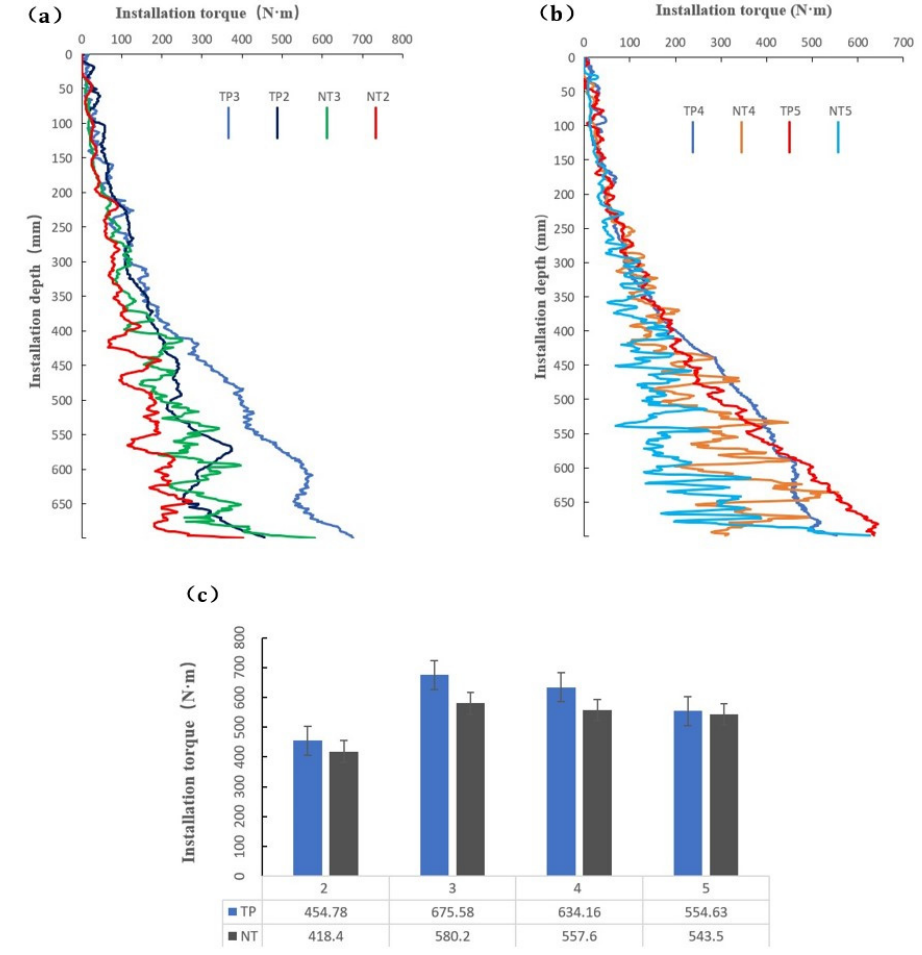
Figure 9. Comparison of test results with numerical simulation results: ( a ) screw piles with different diameter; ( b ) screw piles with different pitch; ( c ) the Max installation torque of four screw pile.